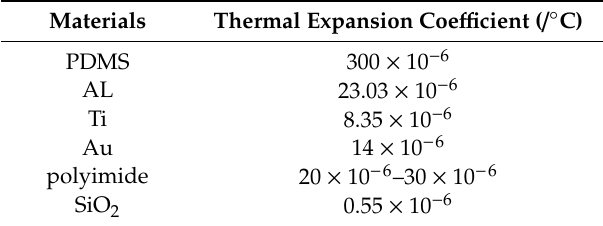
Table 1. The thermal expansion coe ffi cients of materials at room